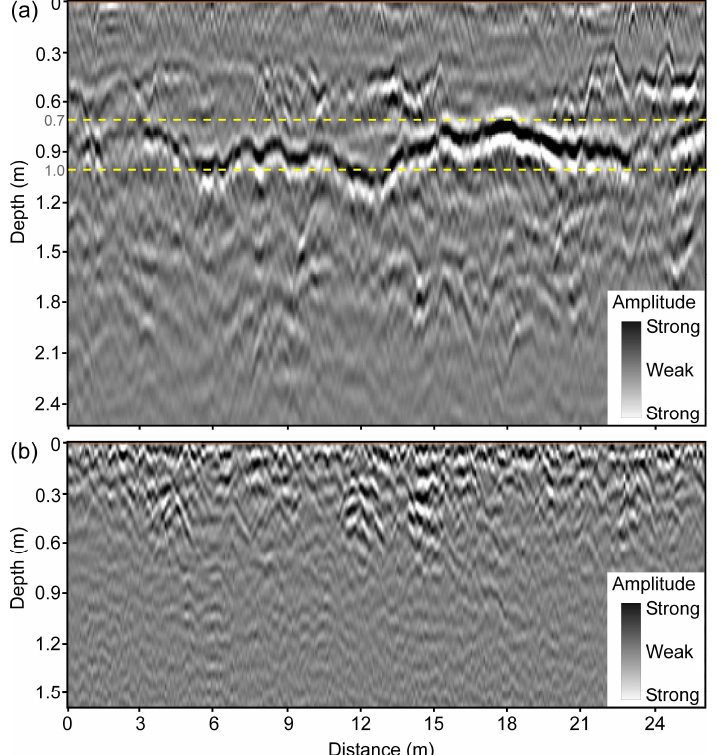
Figure 9. An example of the GPR profiles from the Holtum and Lillebæk-2 sites, respectively showing: ( a ) strong reflections from the soil layer boundary and deep penetration depth (~2.0 m) and ( b ) limited penetration depth (~0.6 m) of the 3D-GPR signal. The yellow lines were marked to indicate the depth of 0.7–1.0 m where a large SD was observed in the 3D-GPR signal magnitude at the Holtum